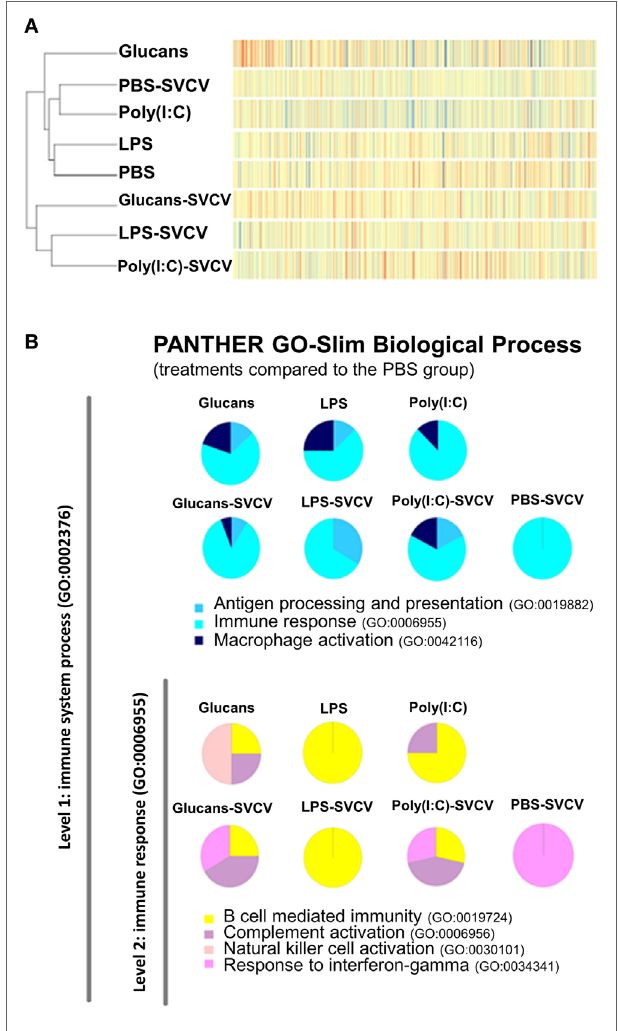
FigUre 3 | Similarity analysis of the transcriptome response at 35 days post-immunostimulation in the presence or absence of Spring Viremia Carp Virus (SVCV) infection. (a) Dendrogram and heatmap representing the overall microarray results. The samples were divided into two clusters, one containing the pathogen-associated molecular patterns (PAMP)-stimulated groups and the individuals infected in the absence of pre-stimulation, and the other including the groups that were pre-stimulated with PAMPs and then infected with SVCV. In both clusters, the β -glucans formed a separate branch, indicating that this stimulus induced the most differential response. (B) Functional classification of DEGs in the zebrafish kidney between the different treatments and the phosphate-buffered saline-treated group according to Slim Biological Process Gene Ontology Terms. The level 1 category “Immune System Process” was selected, and within that category, the level 2 category “Immune Response.” After SVCV challenge, the gene categorization was conditioned by previous stimulation with a